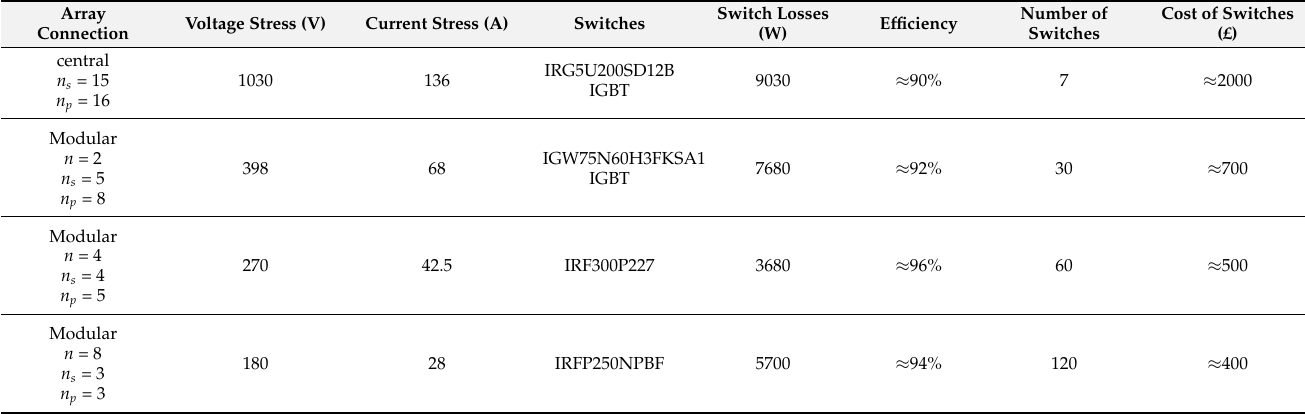
Table 8. Numerical comparison between the central and modular